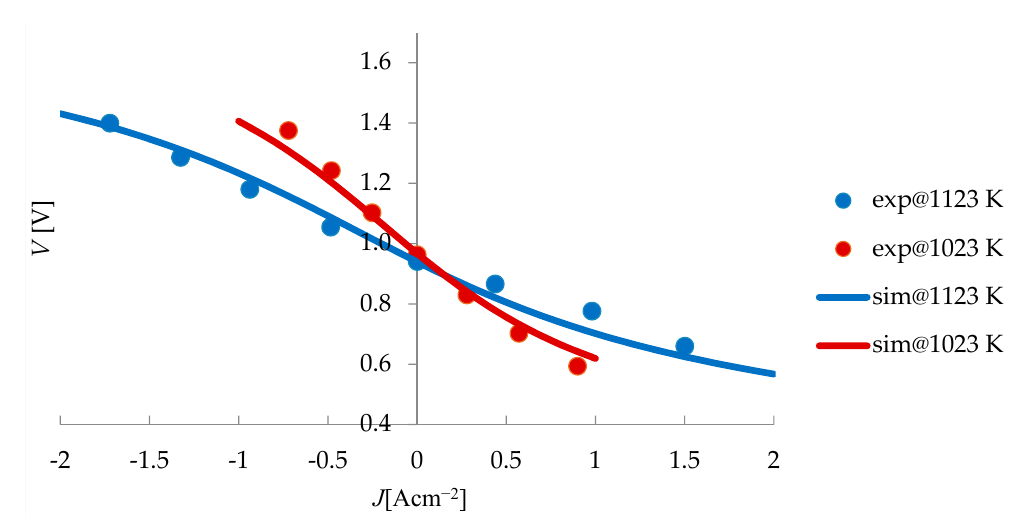
Figure1. Figure 1. Polarization curves validation of a small-SIZED single rSOC though the 0D modeling approach.